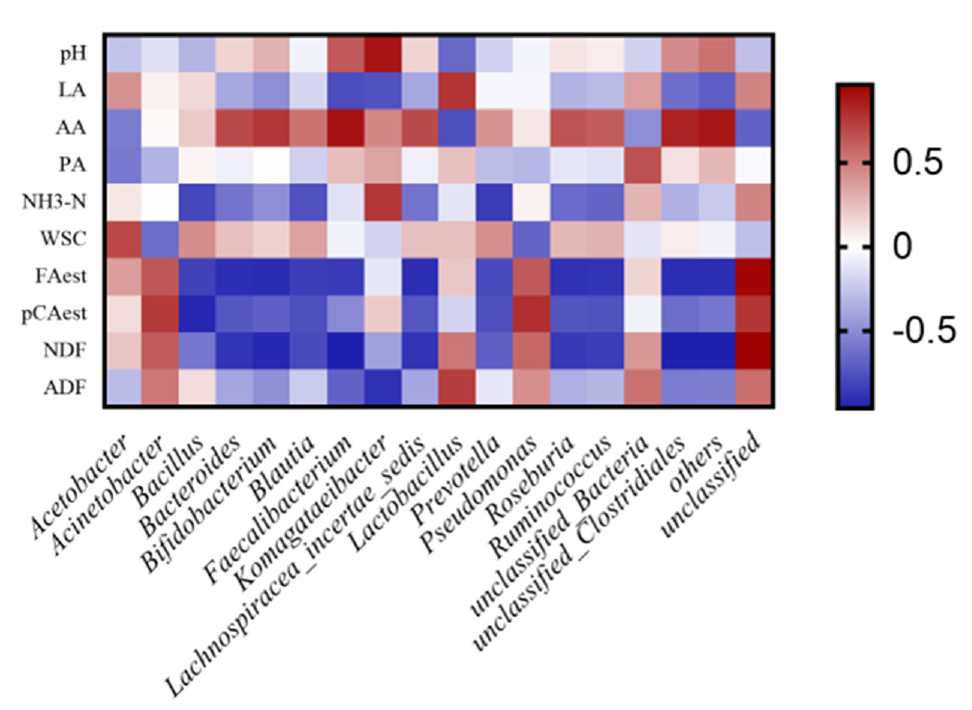
Figure 4. Spearman correlation heatmap of the top tenth of genera and fermentation properties. X and Y axis are environmental factors and genus. R in different colors to show, the right side of the legend is the color range of different p values.